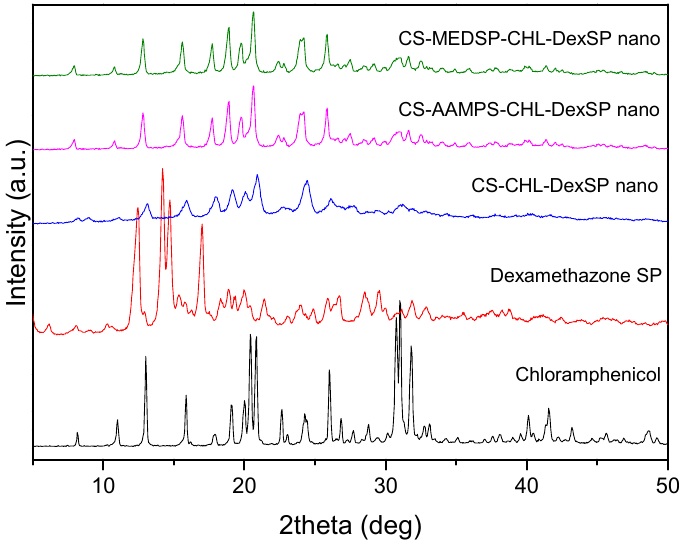
Figure 7. XRD patterns of neat drugs and encapsulated in CS, ACS-AAMPS and CS-MEDSP